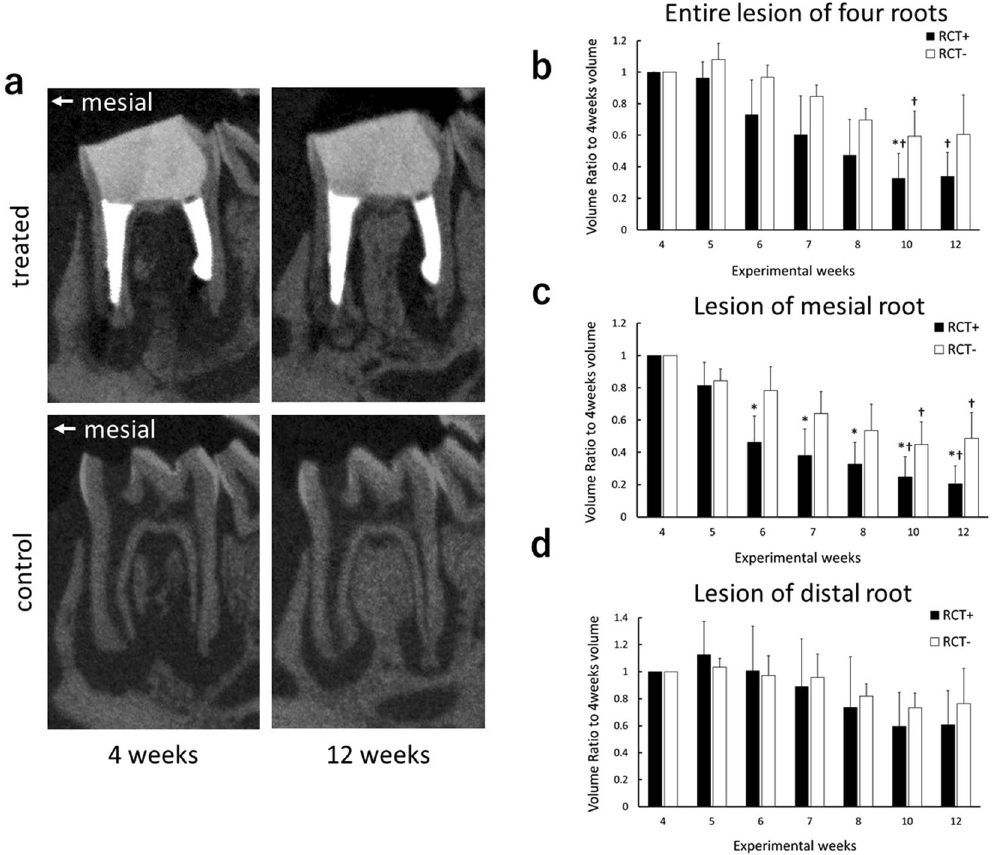
Figure 4. Micro-CT analysis of periapical lesions after root canal treatment in rat. ( a ) Representative micro-CT images of experimental teeth in the treatment group, and the control group, at the 4-week and 12-week time points. ( b – d ) Comparison of changes in the volume of periapical lesions ( * P < 0.05 indicates significant differences compared with the control group at the same time point, Welch’s t -test; † P < 0.05 indicates significant differences compared with the 4-week data of the same group, Kruskal-Wallis test). Data represent the means of five sample measurements; error bars indicate standard deviations. The volume of the periapical lesions of the mesial root for the treatment group were significantly lower than that of the control group at each time point after 6 weeks following pulp exposure.